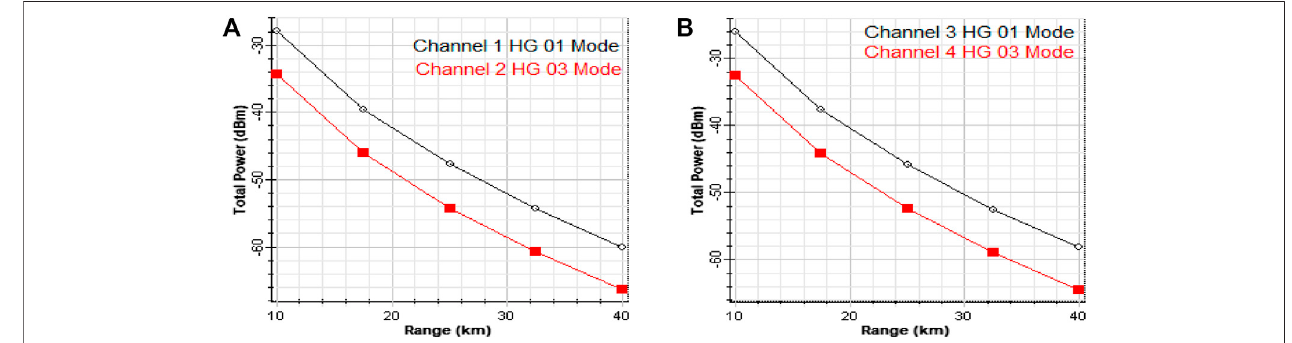
FIGURE 5 | Signal power for (A) 1931. THz channel and (B) 193.2 THz channel under clear